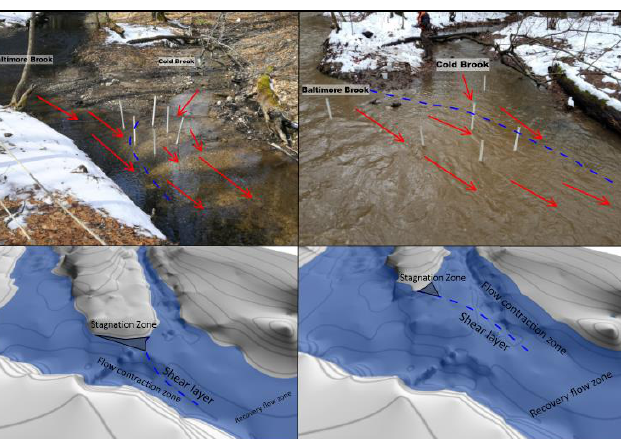
Figure 5. Pictures of the confluence flow during low-flow ( top left , 17 March 2019) and high-flow ( top right , 2 December 2018) conditions, and 3D maps with the hydrodynamic features at a confluence ( bottom ).